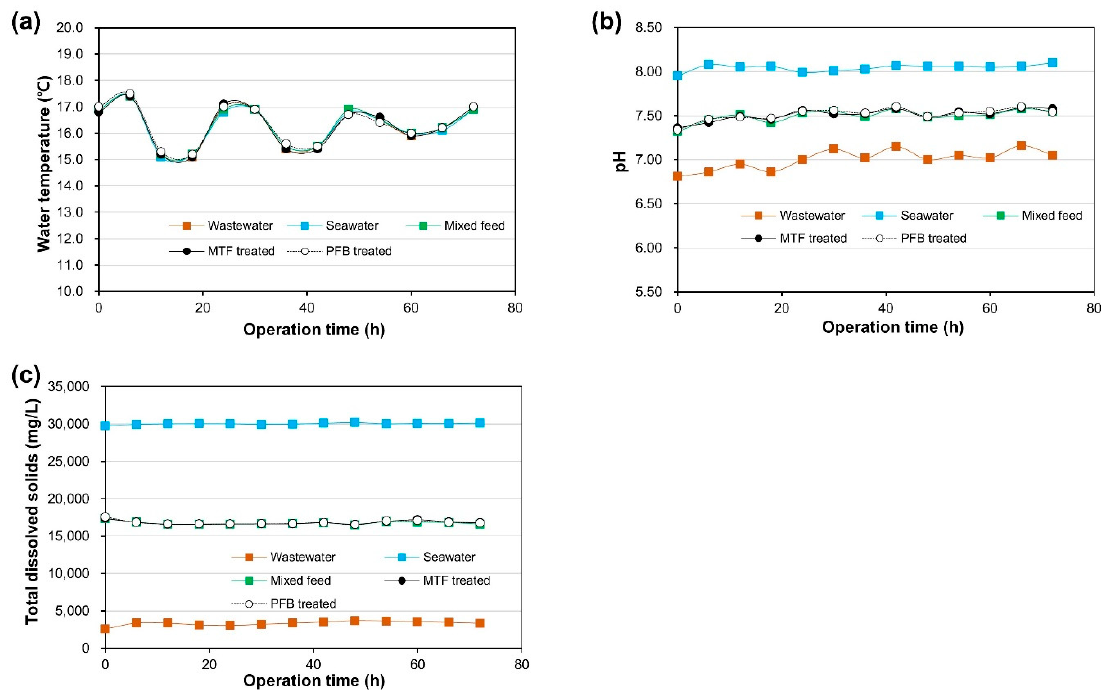
Figure 4. Characteristics of influent water during MTF and PFB field experiments (November 2019): ( a ) influent water temperature, ( b ) influent water pH, and ( c ) influent water total dissolved solids (TDS).